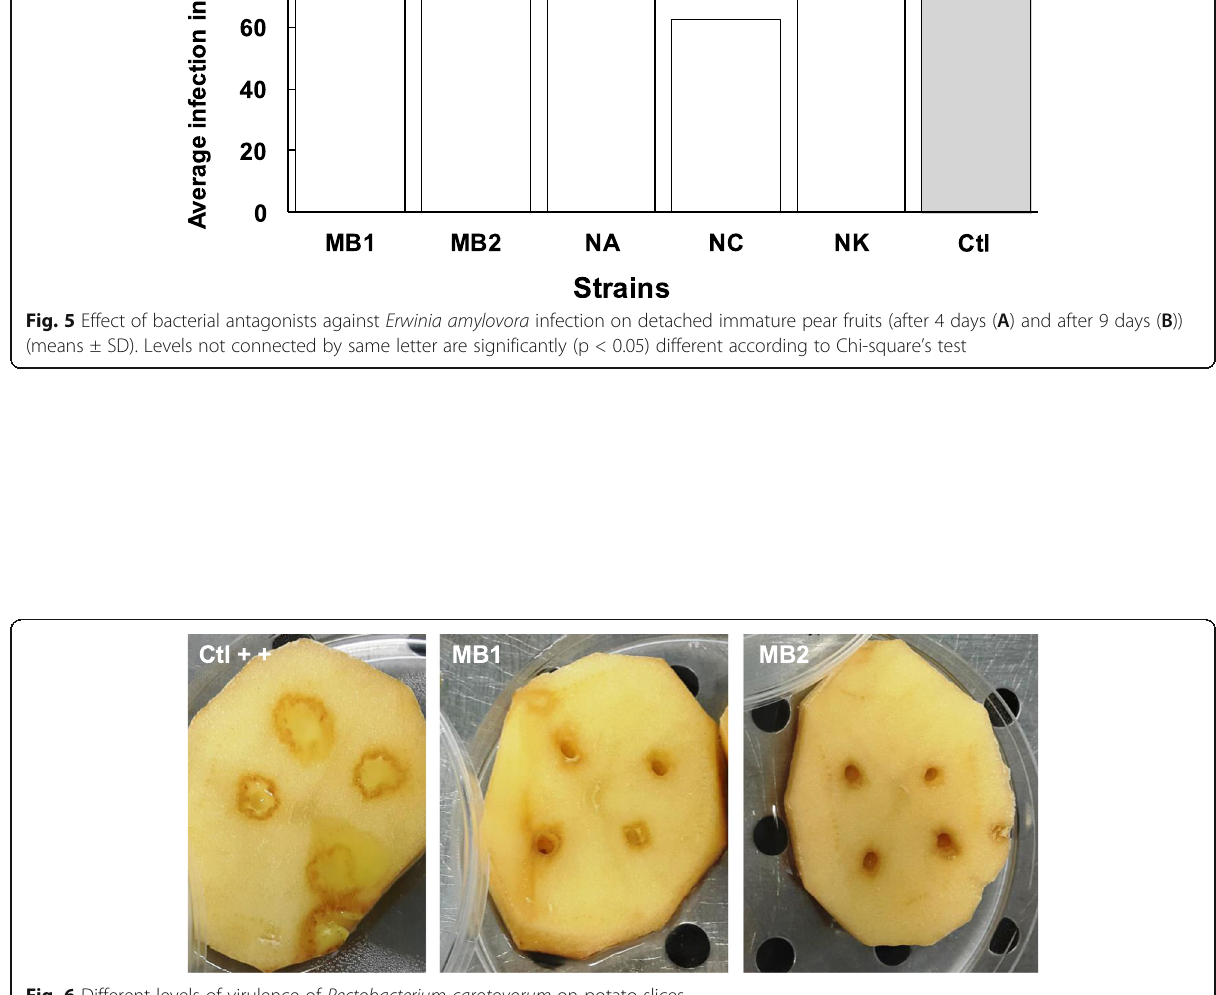
Fig. 6 Different levels of virulence of Pectobacterium carotovorum on potato